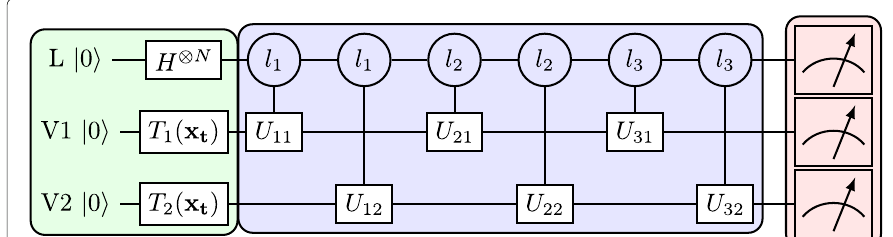
Fig. 6 Sketch of the main circuit for Method II: Qubits in the main circuit can be divided into two groups: One group will represent the sub labels, and will play the role of control bits, as the L part in the figure. The other will represent the given vector, as the V part in the circuit. Furthermore, qubits representing the vectors are divided into a few groups (In this Figure, 2 groups), and the sublabel qubits will control them respectively. We needtomeasureallofthemtogetourresults.Connectionbetweenthe V